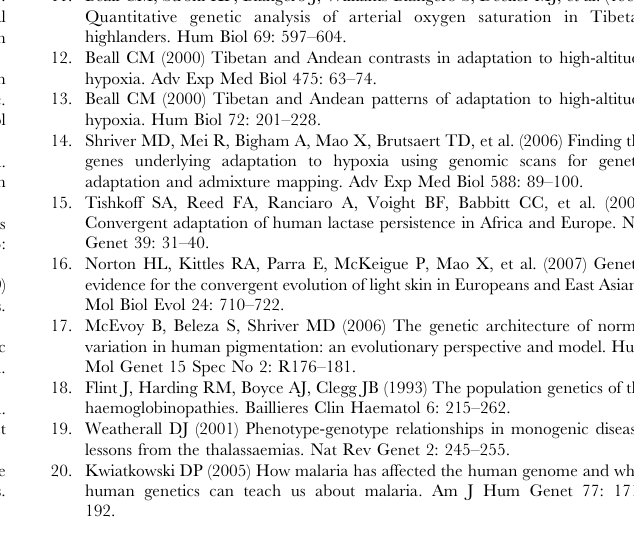
Table S2 Genes encoded by the four consecutive one megabase windows on chromosome 12 spanning 109,000,000 bp to 113,000,000 bp that were significant for the hypergeometric distribution.